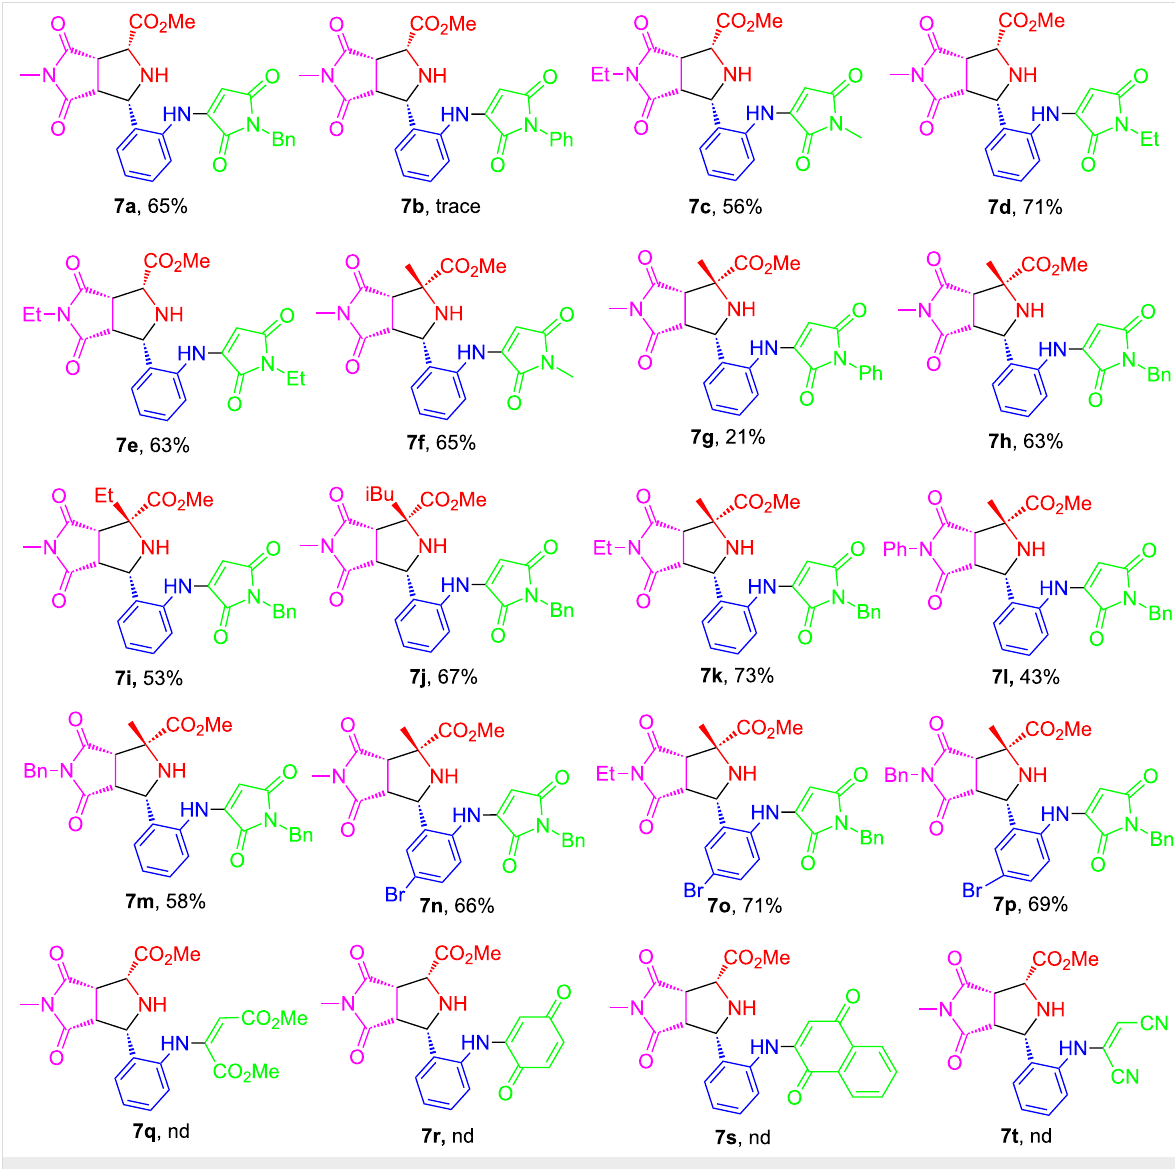
Figure 2: One-pot double [3 + 2] cycloadditions and denitrogenation for product 7 under the optimized reaction conditions, see Table 1, entry 5. nd = not